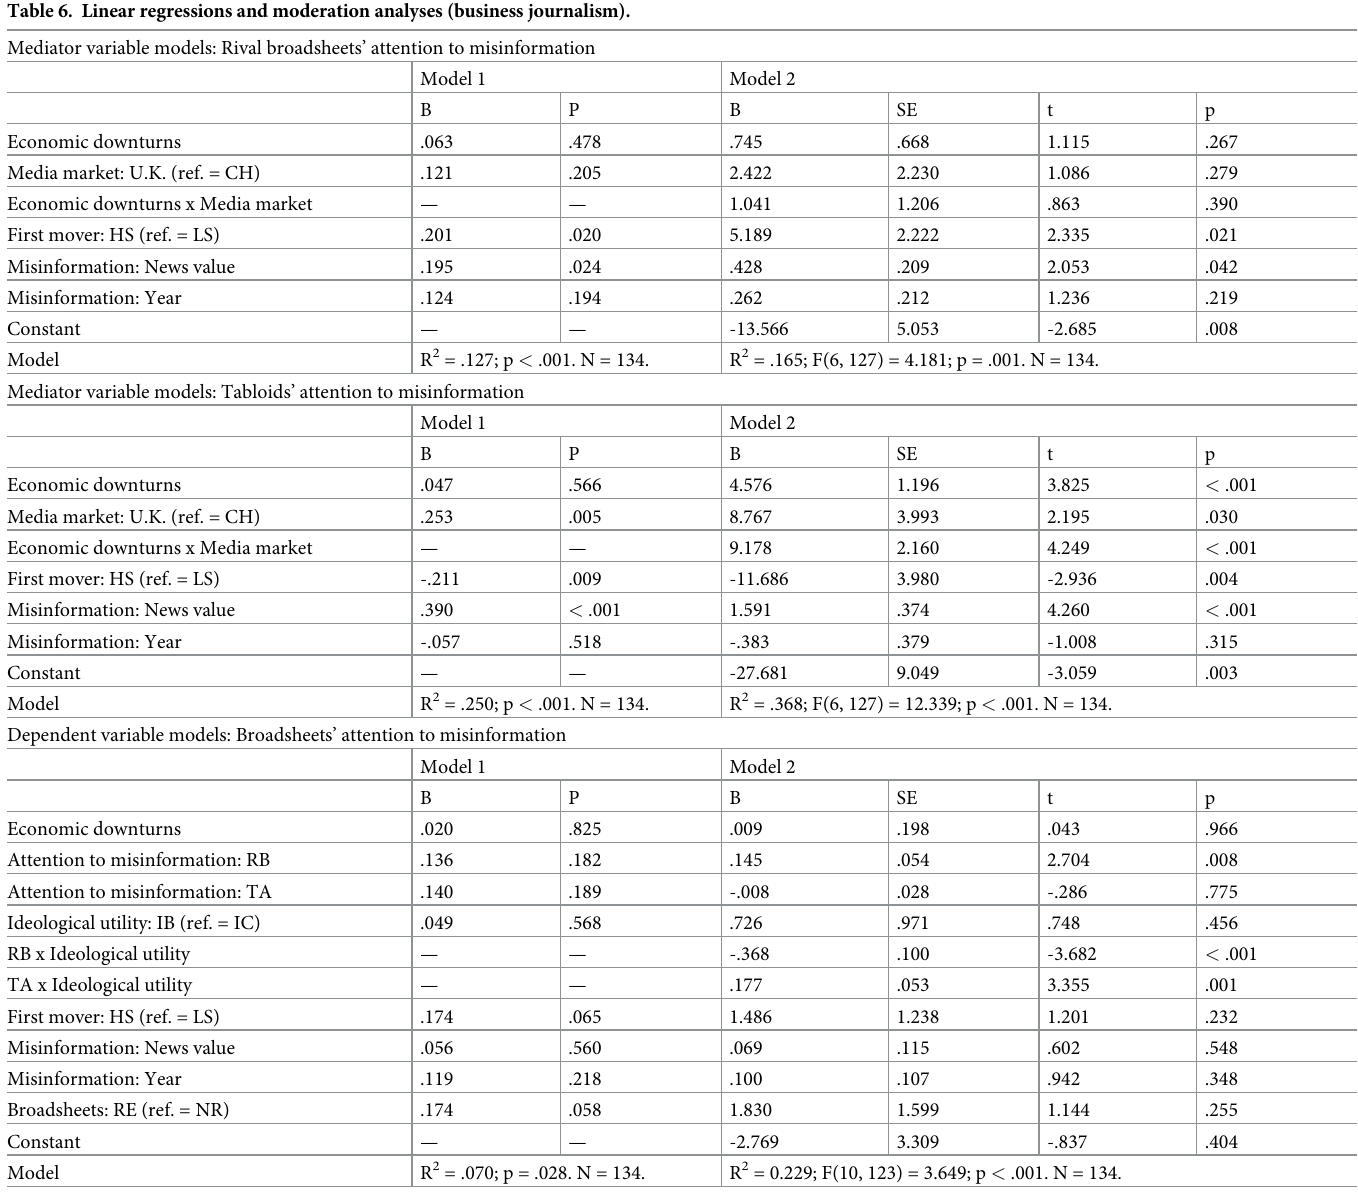
Table 6. Linear regressions and moderation analyses (business